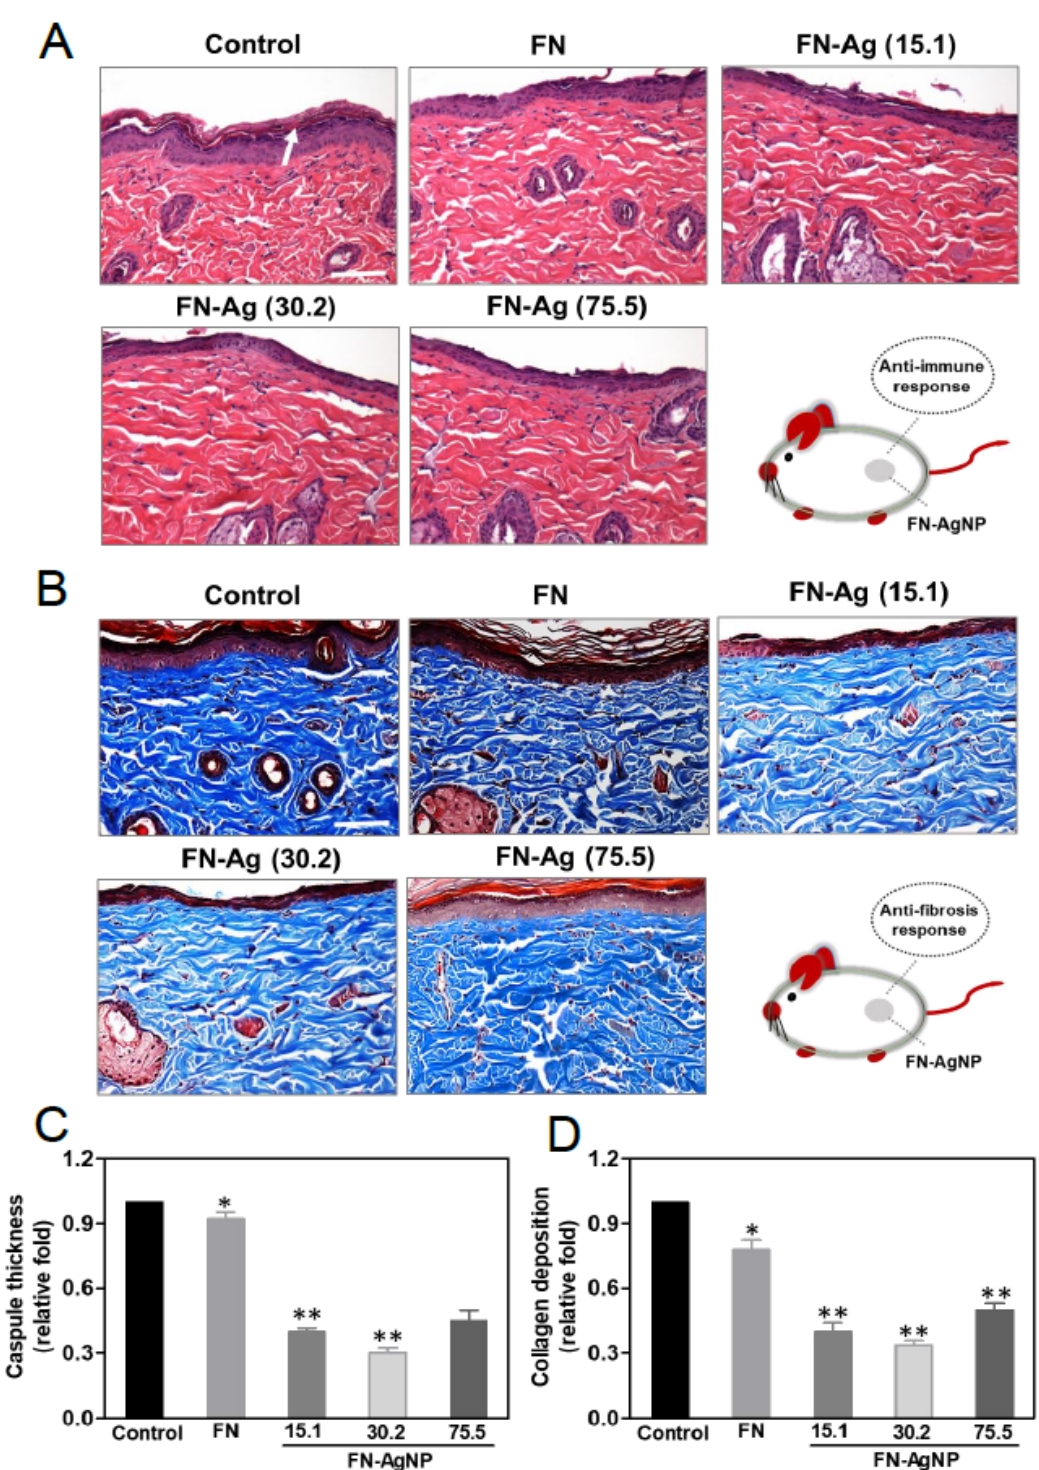
Figure 6. Subcutaneous implantation to measure the foreign body reactions induced by various nanomaterials. After four weeks of implantation, ( A ) H&E staining, white arrows indicate the thickness of the capsule, and ( B ) Masson’s staining were applied to process further investigations. Scale bar = 100 μ m. ( C , D ) Semi-quantification of capsule thickness and collagen deposition was revealed based on the histology examination. Control group = glass cover slide. * p < 0.05; ** p < 0.01: less than the control ( n =